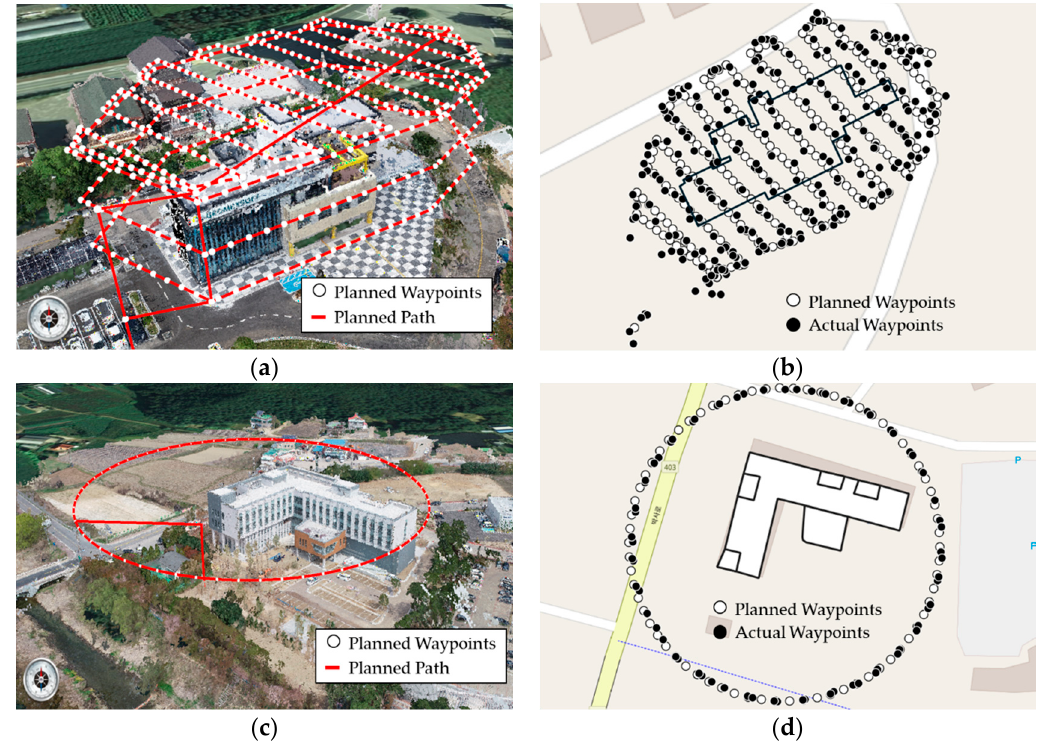
Figure 10. ( a ) Path planning in the simulator and ( b ) waypoints comparison near the Geomexsoft building for scenario 1. ( c ) Path planning in the simulator and ( d ) waypoints comparison near the Research Institute for Gangwon building for scenario 2.